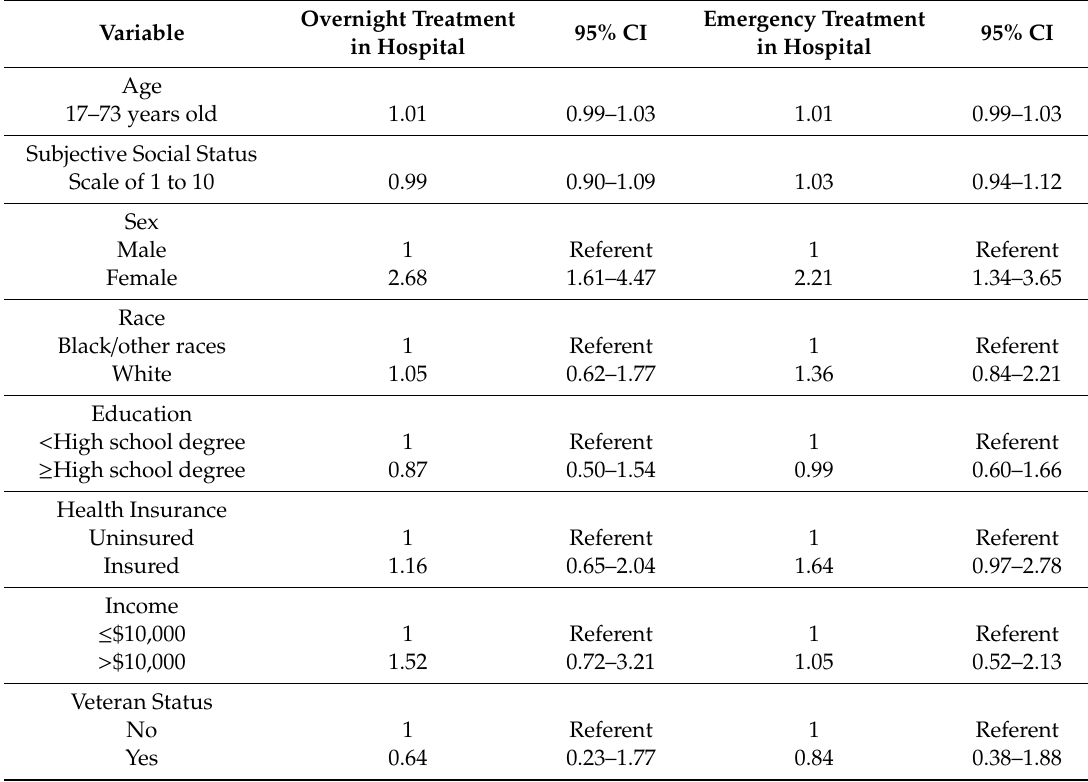
Table 2. Predictors of Overnight and Emergency Treatment in Hospital among a Sample of Homeless Adults (N =